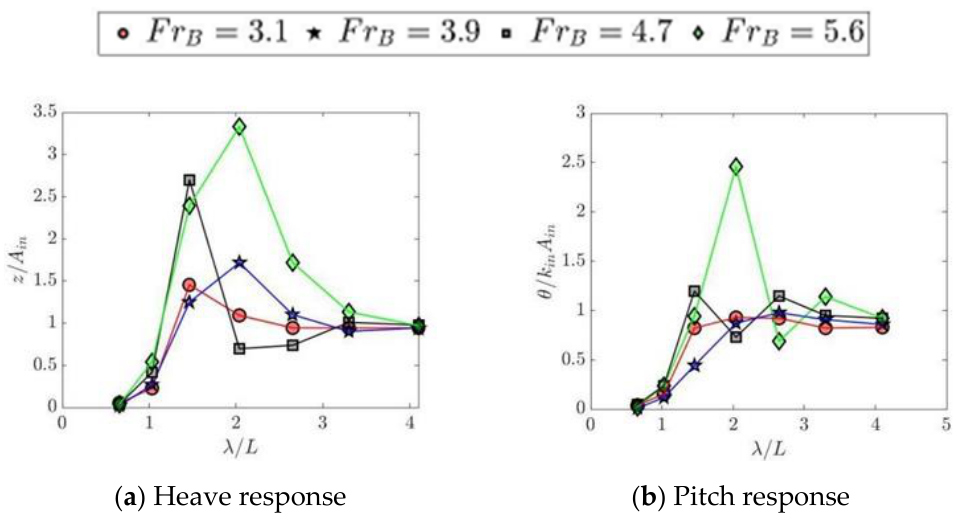
Figure 7. Heave ( a ) and pitch ( b ) responses of Model B in different forcing conditions.